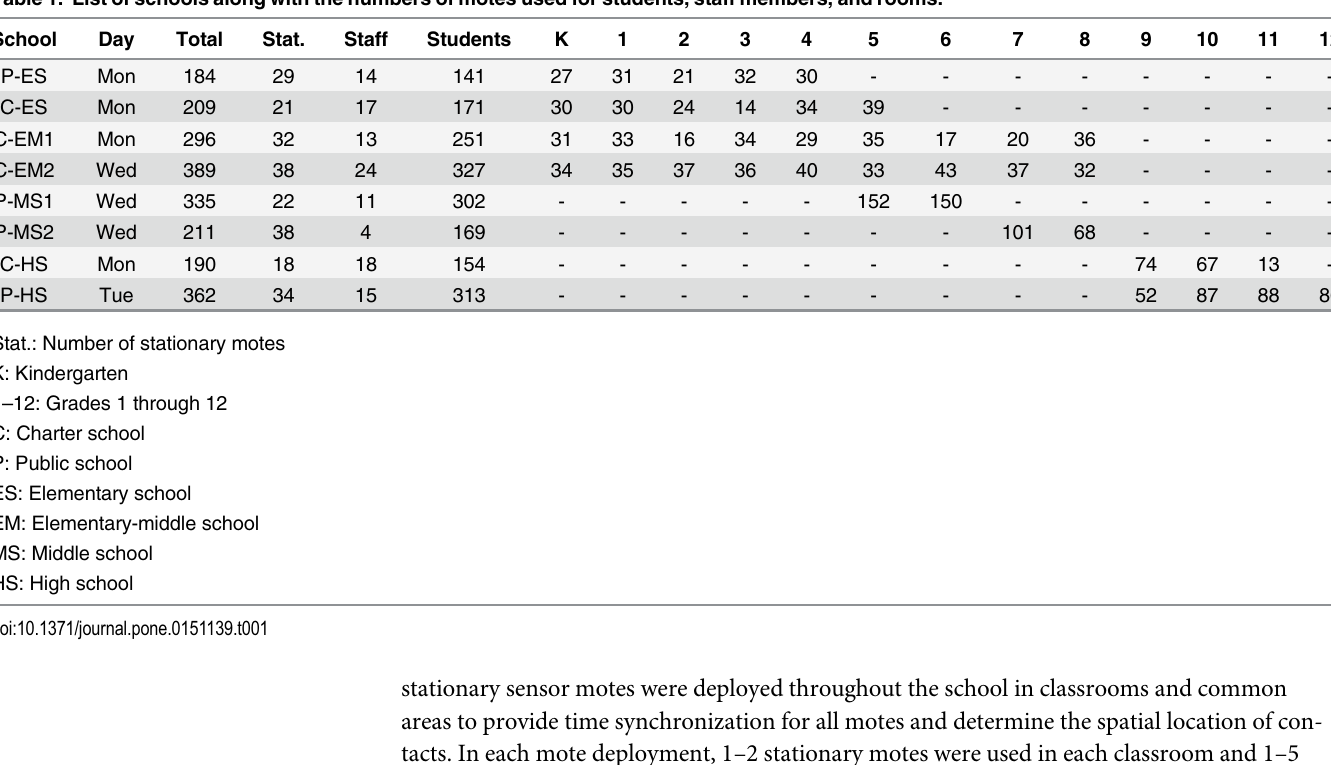
Table 1. List of schools along with the numbers of motes used for students, staff members, and